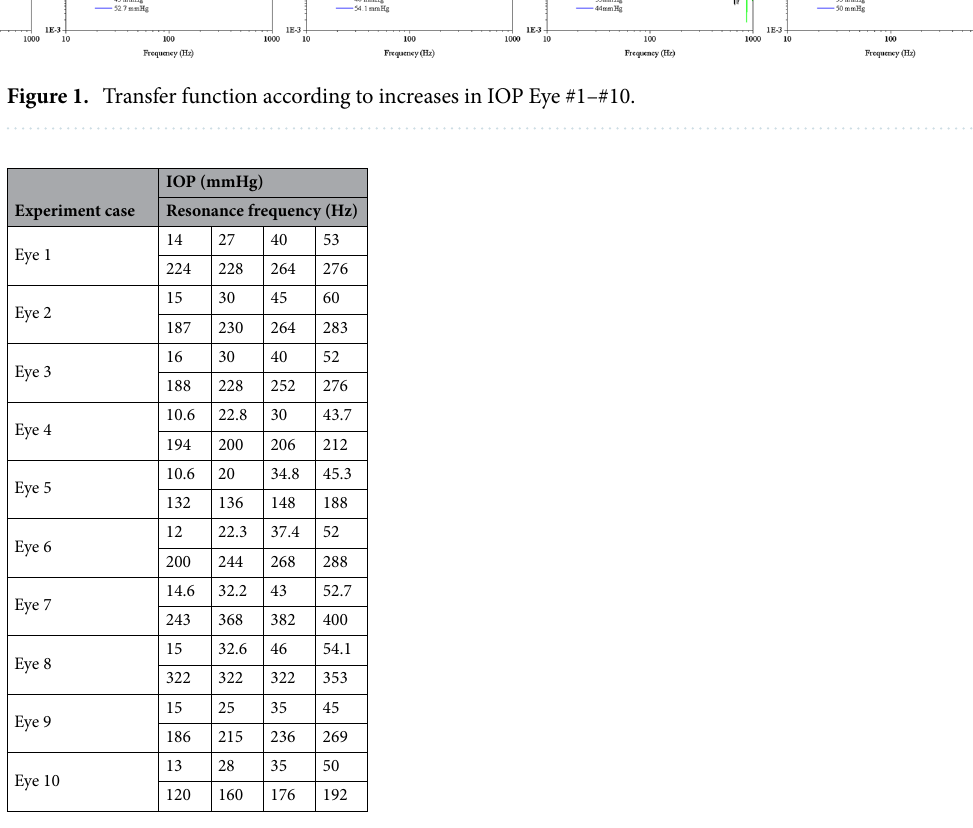
Table 1. Resonance Frequency Changes with Changes in IOP. IOP intraocular